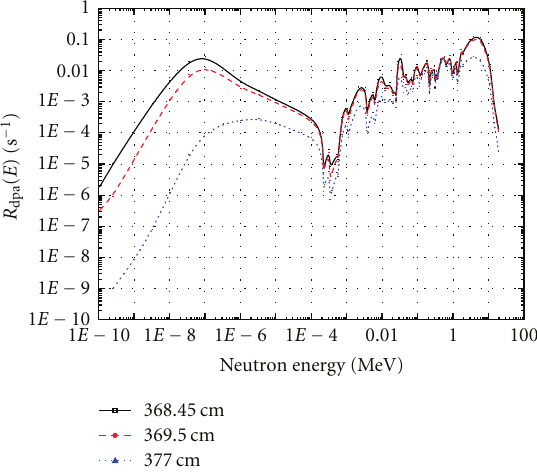
Figure 10: DPA rate versus neutron energy on the inner surface of the cladding, on the inner surface of the RPV, and 1 / 4 · T for θ = 28 . 44 ◦ and Z = 33 . 75cm.